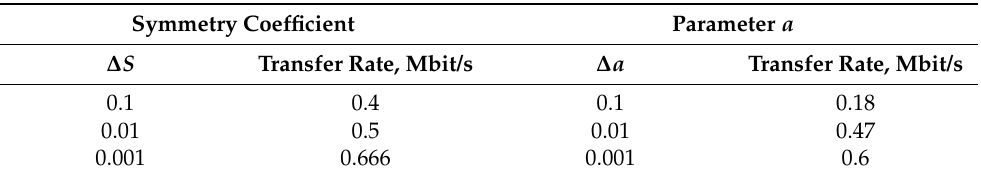
Table 1. The comparison between dependence of the binary data transfer rate on the difference between symmetry coefficients and parameters a with a defined minimum synchronization error ∆ x = 10 − 6 ( f samp = 1